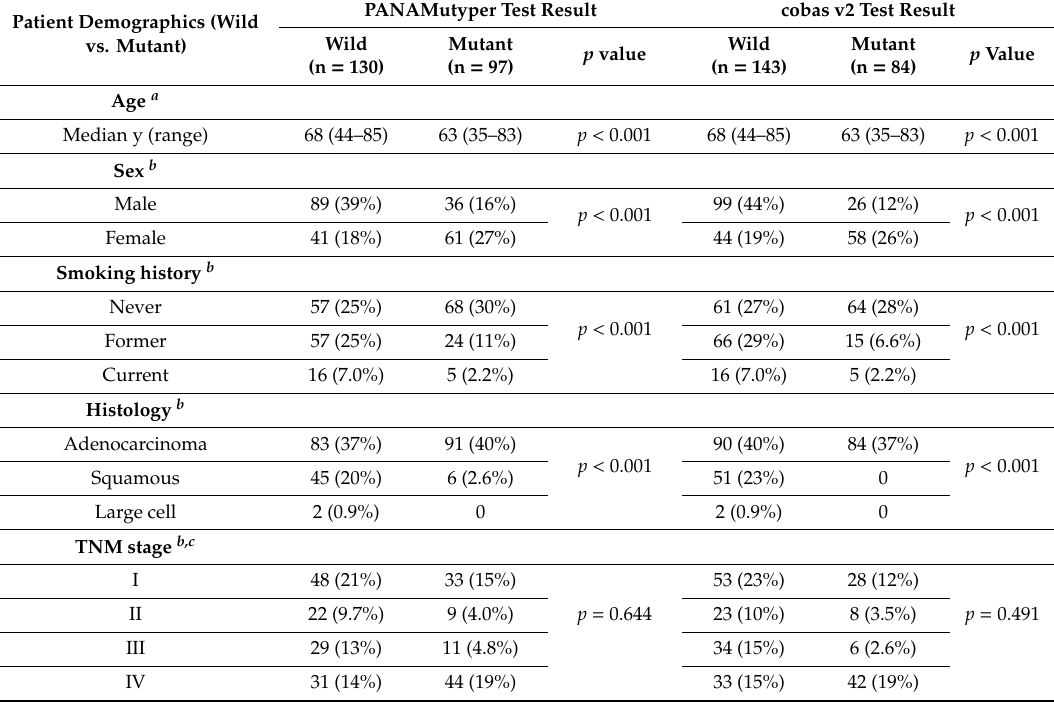
a Independent t -test for EGFR wild vs. EGFR mutant groups diagnosed by the same assay. b Chi-square test for EGFR wild vs. EGFR mutant groups diagnosed by the same assay. c TNM stage was determined at the